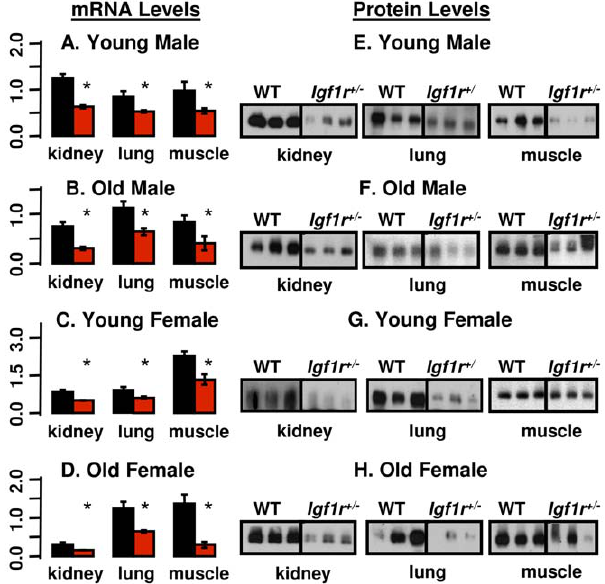
Figure 1. Igf1r b expression. The mRNA and protein levels of the b subunit of Igf1r were measured in the kidney, lung, and muscle (quadriceps) from male and female mice that were 6 (Graphs A, E, C, and G) and 25 (Graphs B, F, D, and H) months old. The graphs on the left represent data from qRT-PCR and those on the right represent data from Western blots. Three to 6 animals were used per group. Black bars represent WT mice and red bars represent Igf1r + / 2 mice; the mean and SEM are shown, and asterisks indicate tissues showing a difference between WT and Igf1r + / 2 where p , 0.05. The Student’s t-test was used for the